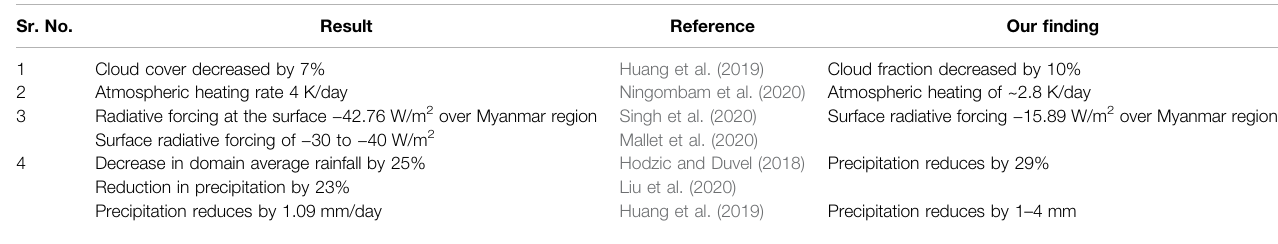
TABLE 1 | A comparison of cloud cover, atmospheric heating, radiative forcing at the surface and rainfall with previous studies. Sr.